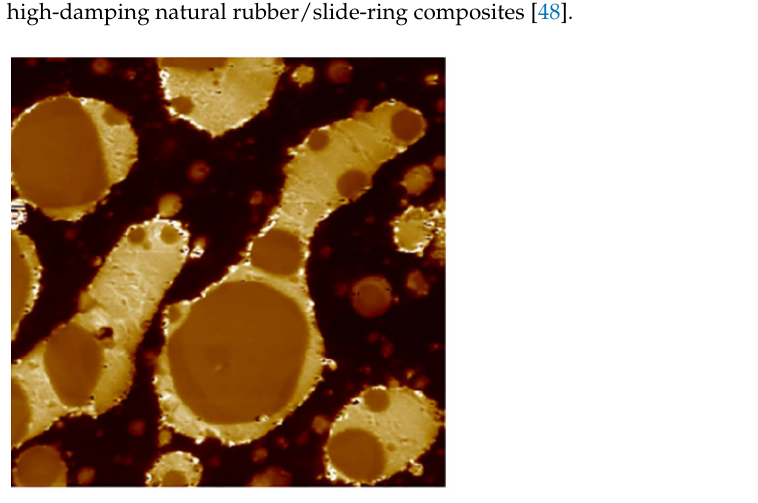
Figure 14. AFM images of NR/ENR/SR (70/30/40) rubber composites